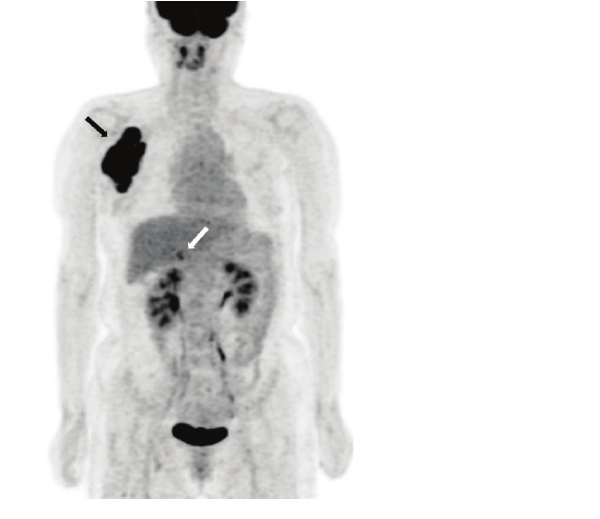
Figure 3: 18 F-FDG-PET scan shows two focal FDG-avid uptakes in the right axilla (SUV max 12.7, black arrow) and right adrenal gland (SUV max 4.7, white arrow). SUV max: maximum standardized uptake value. 18 F-FDG-PET: 18 F-fluorodeoxyglucose-positron emission tomography.